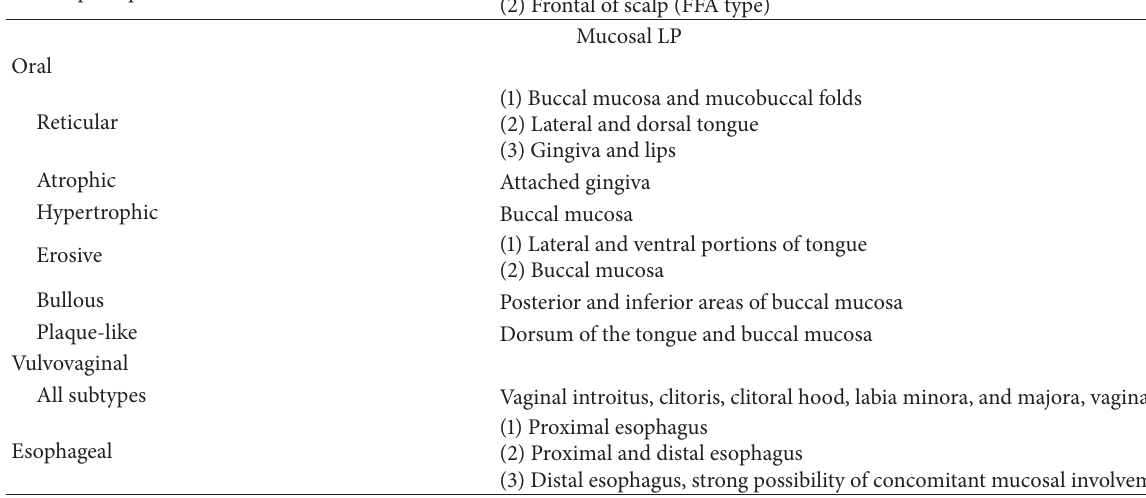
FFA: frontal fibrosing alopecia, CLP: cutaneous lichen planus, LP: lichen